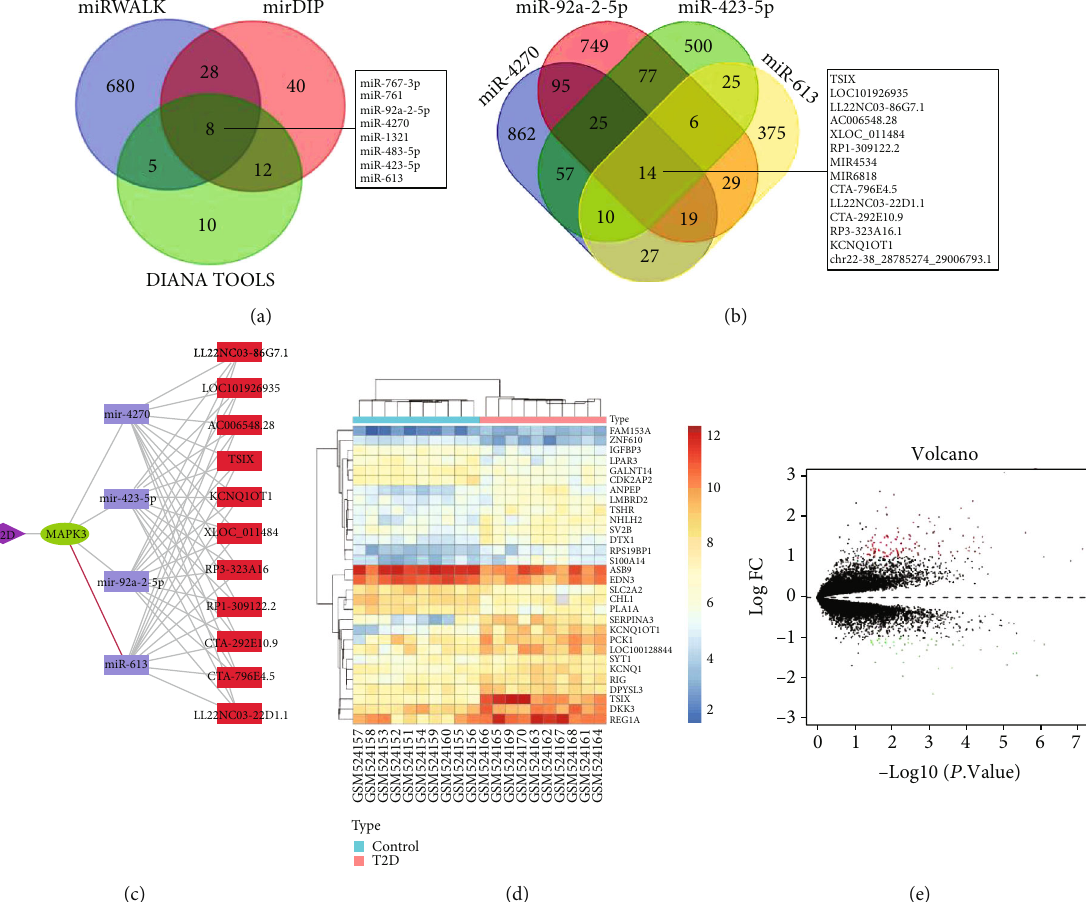
Figure 4: Prediction of upstream miRNAs and lncRNAs modulating MAPK3 by online database. (a) Venn analysis of the upstream miRNAs of MAPK3 predicted by mirDIP, miRWalk, and DIANA TOOLS databases. (b) Venn analysis of the upstream lncRNAs of miR-4270, miR-92a-2-5p, miR-423-5p, and miR-613 predicted by DIANA-LncBase database. (c) Construction of lncRNA-miRNA- MAPK3 coexpression regulatory network by Cytoscape. (d) Heat map of GSE20966 analysis. (e) Volcano plots of